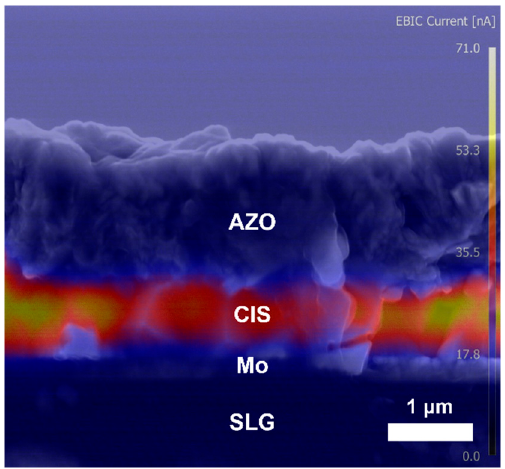
Figure 4. Comparative constituent analysis of the top and bottom layers using ( a ) EDS and ( b ) SIMS.